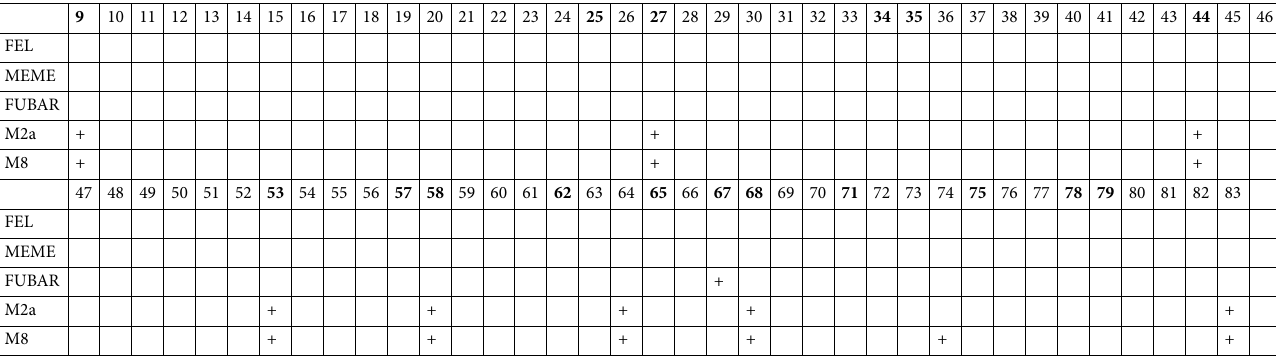
Table 4. Identification of the codons in DAB3 showing the signature of positive selection predicted based on the five different models implemented RDP (using HyPhy package) and CODEML. The codons predicted to be PBR were highlighted by